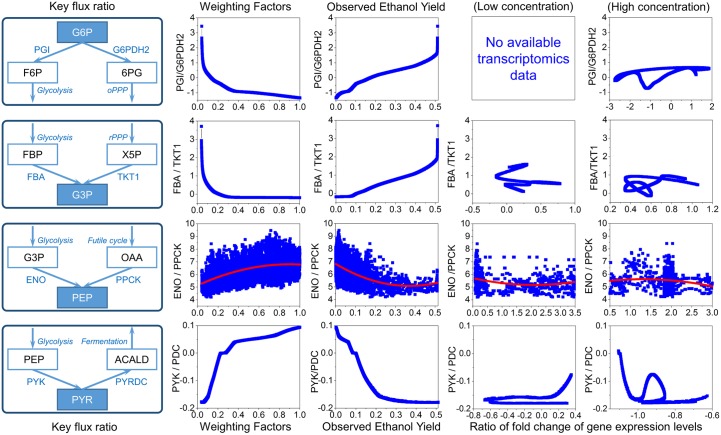
Key flux ratio analysis.Four key flux ratios (PGI/G6PDH2, FBA/TKT1, ENO/PPCK, and PYK/PDC) were selected to be correlated with phenotype-matched weighting factors, observed ethanol yields, and the ratios of the corresponding gene expression levels for low and high glucose condition. All the values of the ratios were exponential. Abbreviations: PGI, glucose-6-phosphate isomerase; G6PDH2, glucose 6-phosphate dehydrogenase; FBA, fructose-bisphosphate aldolase; TKT1, transketolase; ENO, enolase; PPCK, phosphoenolpyruvate carboxykinase; PYK, pyruvate kinase; PYRDC, pyruvate decarboxylase.